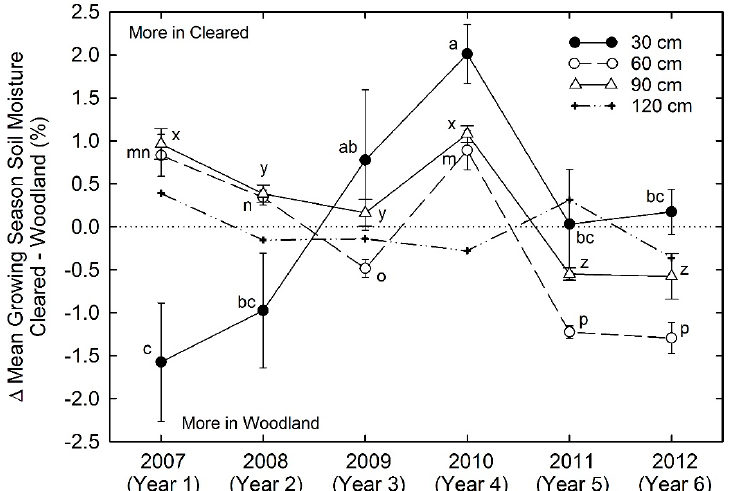
Figure 4. Difference in mean growing season soil moisture between cleared and woodland treatments at each soil depth, 2007 – 2012. Each point represents the mean of all growing season sample dates (April – September) in cleared minus mean of same dates in woodland. Points above zero line indicate more moisture in cleared; below more in woodland. Vertical bars are ±1 standard error (n = 4); not shown for 120 cm depth. Means with different letters within each depth are significantly different at p ≤ 0.05 (30 cm, a – c; 60 cm, m – p; 90 cm, x – z). There were no significant differences at 120 cm depth.